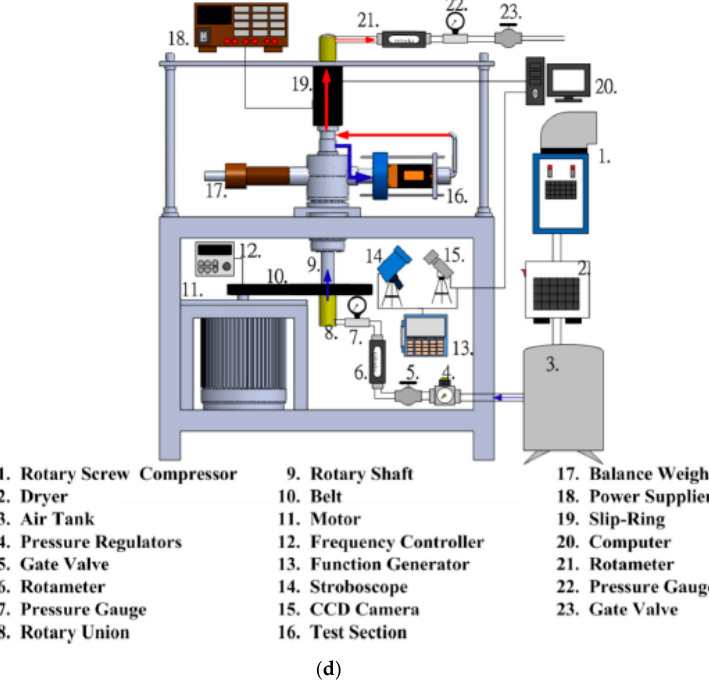
Figure 12. Rotating heat transfer test rigs at, ( a ) University of Florence, Italy [43], Reprint with permission from ASME (order number 1084747), ( b ) Ohio State University, USA [44] ( c ) University of Stuttgart, Germany [45], ( d ) National Chiao-Tung University, Taiwan [46].